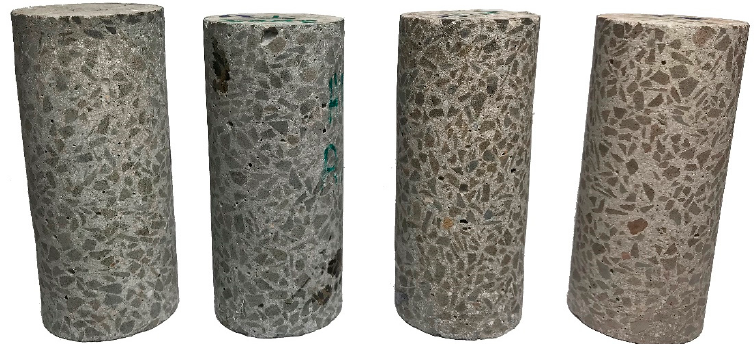
Figure 6. HPFRC 1.1 samples. From left: without heating, 200 °C, 400 °C, 600 °C.